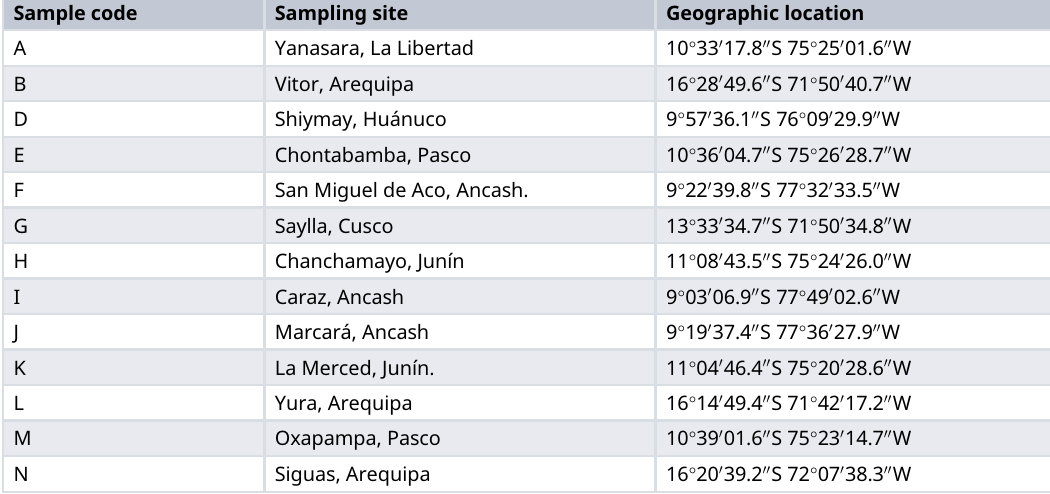
Table 1. List of Peruvian Andean propolis sampling sites. Sample code Sampling